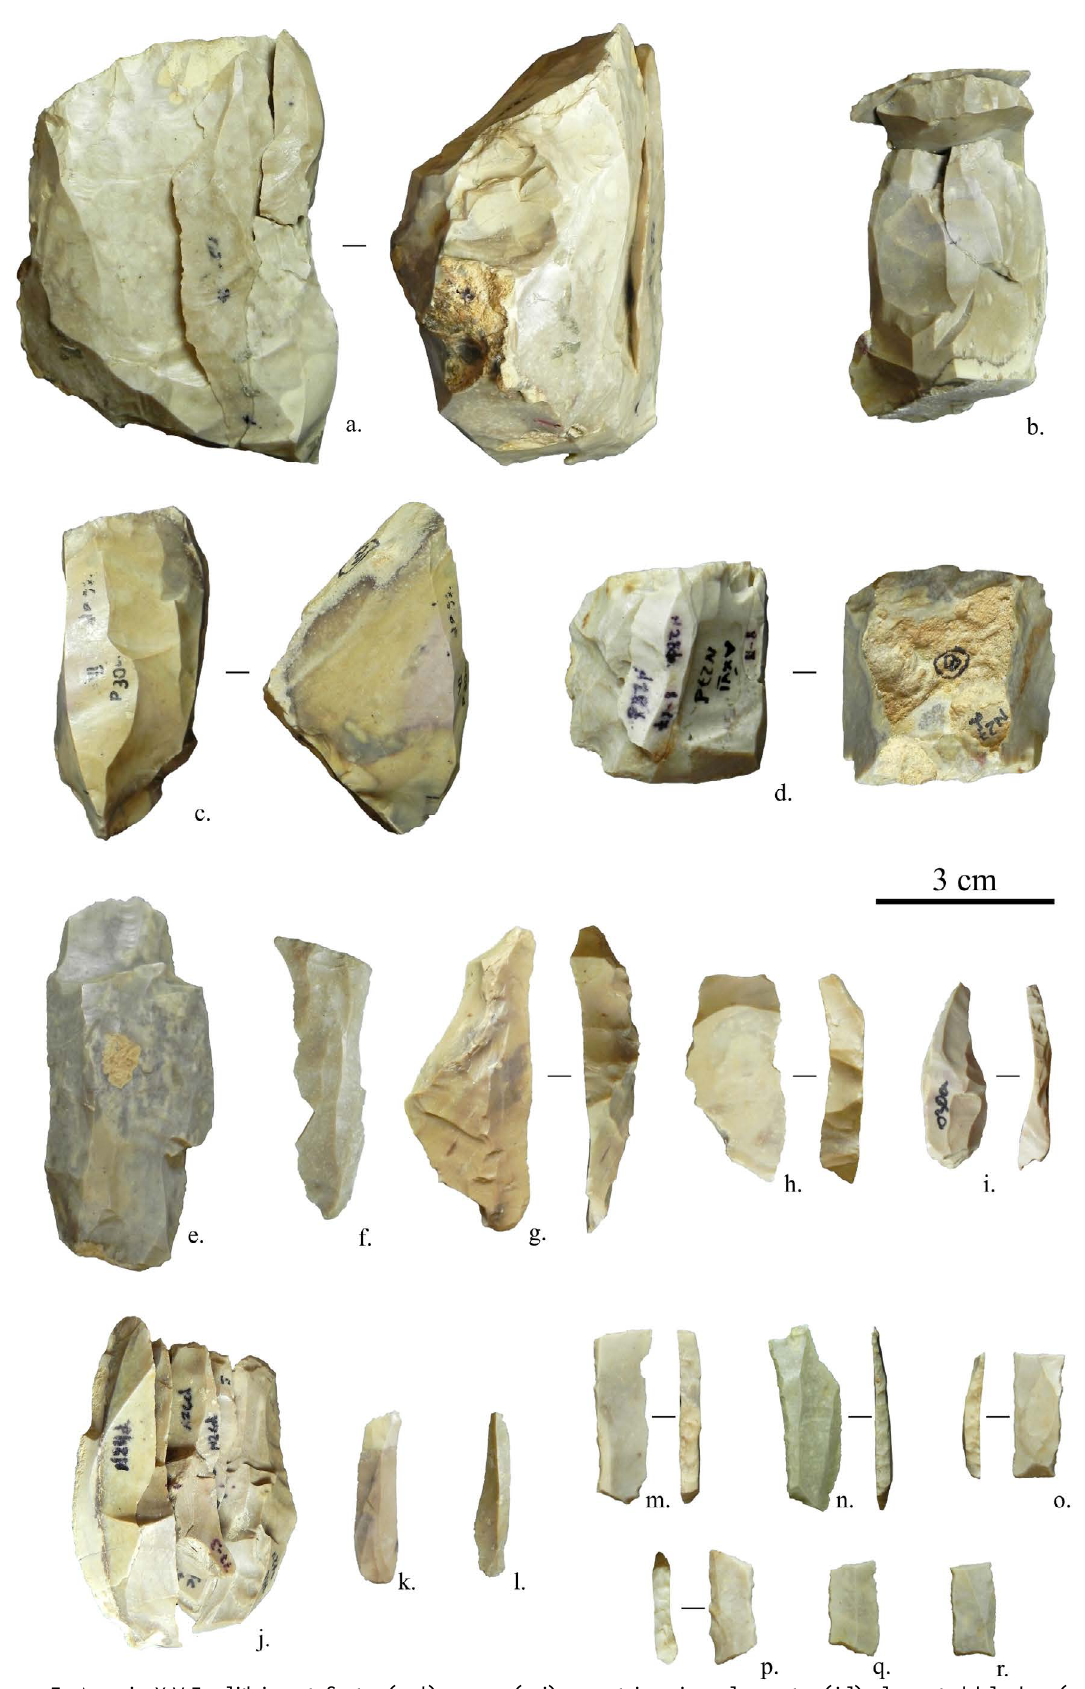
Figure 5. Azariq XVI - lithic artefacts. (a-d) cores, (e-i) core trimming elements, (j-l) elongated blanks, (m-r) geometric microliths (trapezes and